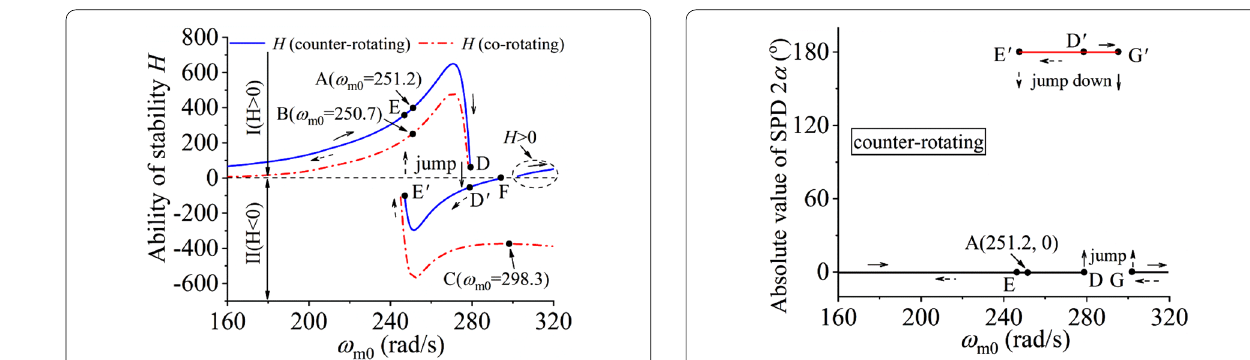
Figure 2 Coefficients of the ability of stability versus ω m0 Figure 3 Absolute values of SPD versus ω m0 for two counter-rotating vibrators